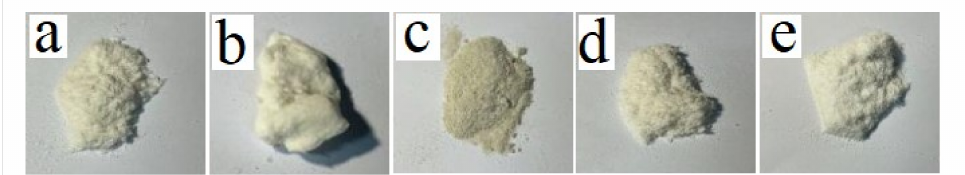
Figure 1. Examples of CMC powders from ( a ) pine wood, ( b ) bamboo, ( c ) pine needles, ( d ) bamboo leaves, and ( e ) hemp hurd.